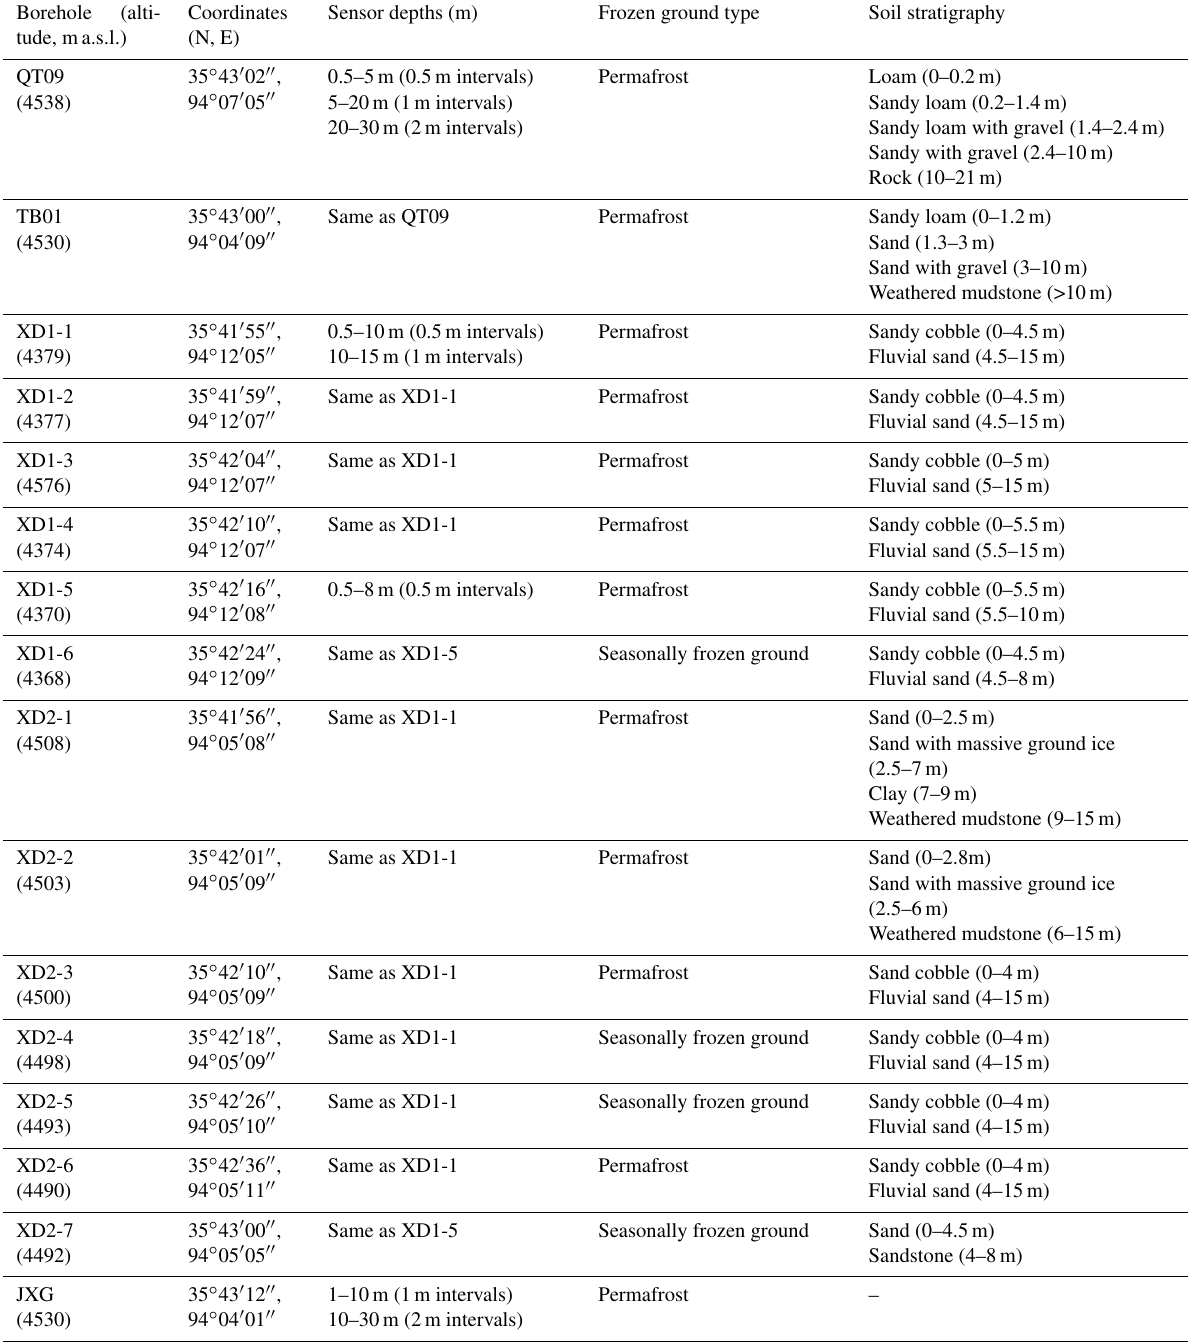
Table A1. A list of monitoring boreholes in the study area and a summary of the ground properties are shown. Borehole tude,